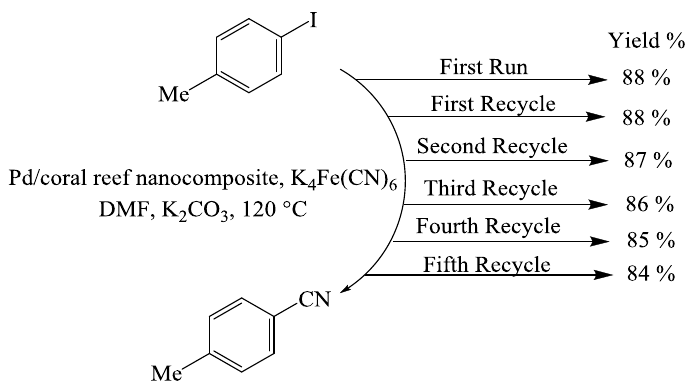
Figure 10. Reusability of Pd/coral reef nanocomposite for cyanation of 4-iodotoluene using K 4 Fe(CN) 6 .